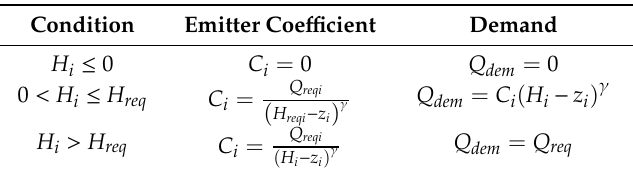
Table 1. Operating range of emitter coefficients.